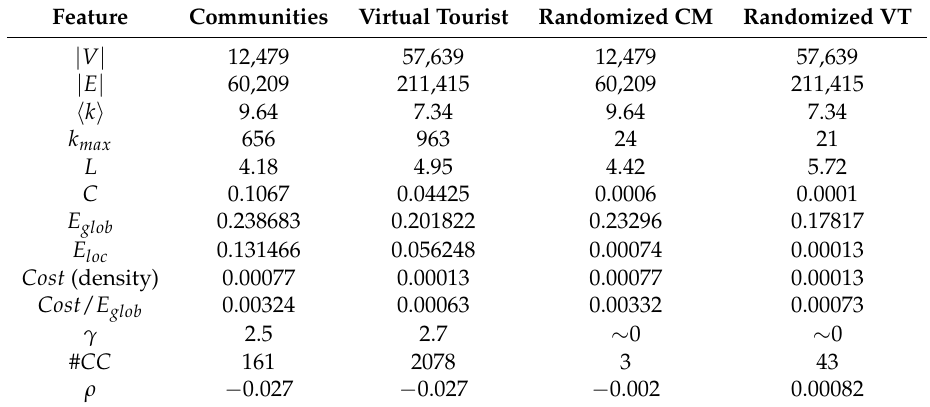
Table 1. Statistical features of the Communities and Virtualtourist online social networks, together with randomized versions of the same networks: number of nodes | V | , number of edges | E | , average node degree (cid:104) k (cid:105) , maximum degree k max , average shortest path L and average clustering coefficient C (for the largest connected component), global efficiency E glob , local efficiency E loc , cost, cost over efficiency, exponent